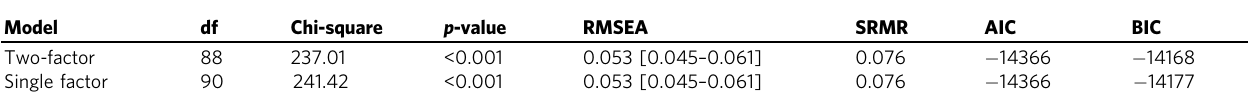
df degrees of freedom, RMSEA root-mean-square error of approximation, SRMR standardized root-mean-square residual, AIC Akaike information criterion, BIC Bayesian information criterion. For each model, the number of observations was N = 605. As the con fi rmatory fi t index (CFI) was not consistently generated, possibly due to challenging model estimation, we here report only the fi t statistics generated for every model. The p -values refer to the chi-squared test (a one-sided test). Source data are provided as a Source Data fi